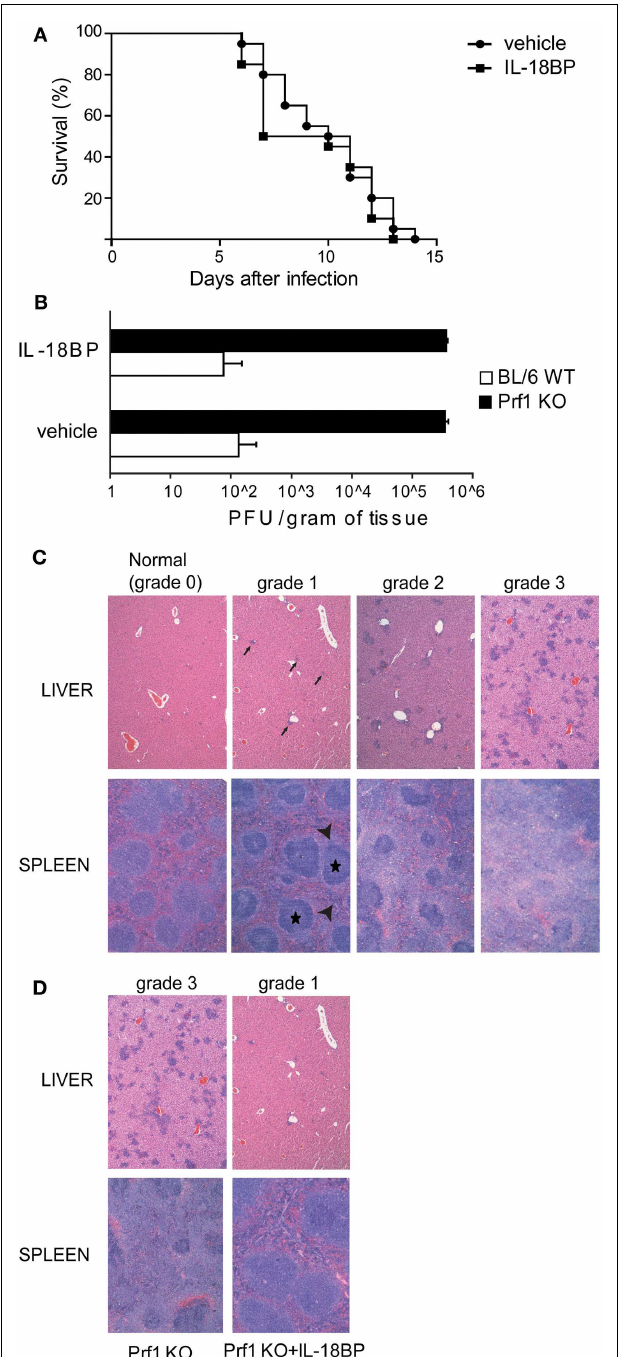
FIGURE 2 | IL-18BP does not improve Prf1 KO mice survival after mouse CMV (MCMV) infection but consistently reduces inflammatory lesions in the liver and spleen. (A) Kaplan–Meier survival curves for Prf1 KO mice infected with 1.5 × 10 4 PFU of MCMV, treated or not with IL-18BP. N = 20 mice per group. (B) MCMV titers in liver homogenates of BL/6WT and Prf1 KO mice, with or without IL-18BP, 6days after infection.The data are expressed as mean ± SEM. N = 3 mice per group. (C) Histological score of liver and spleen sections from MCMV‘infected mice, stained